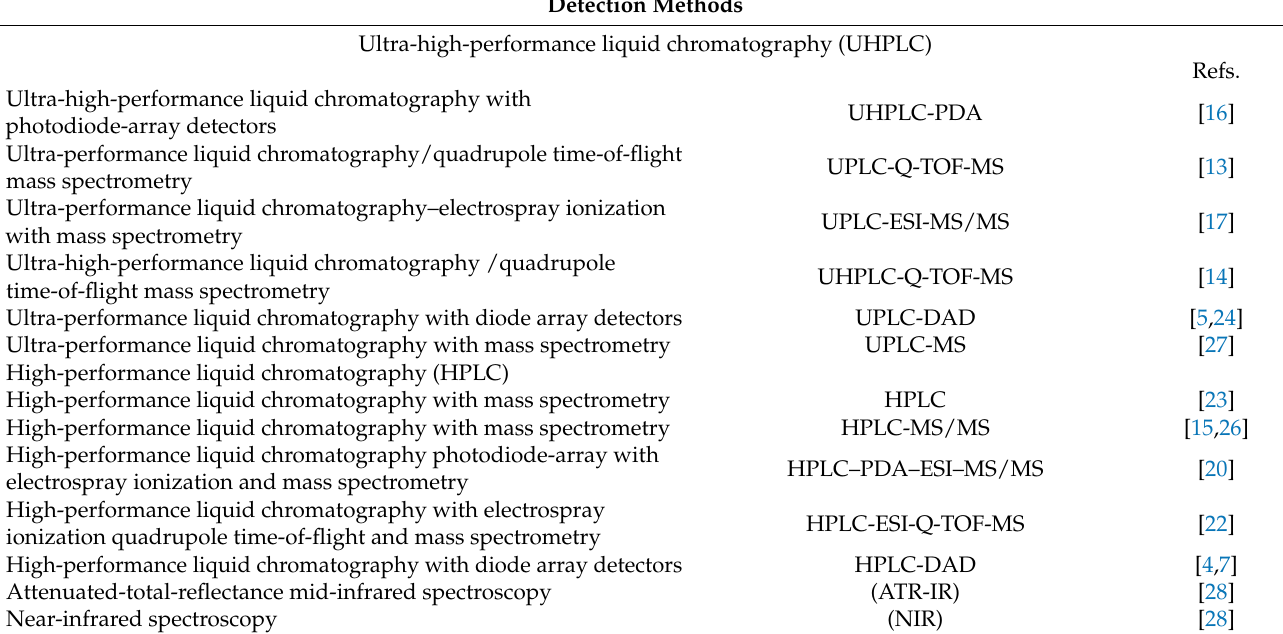
Table 1. Detection methods of baicalin ( 1